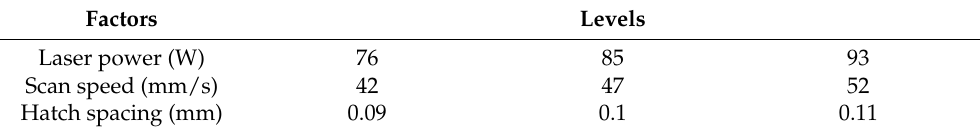
Table 1. DoE factors and levels. Factors Levels Laser power (W) 76 85 93 Scan speed (mm/s) 42 47 52 Hatch spacing (mm) 0.09 0.1 0.11 The layer thickness was fixed at 0.03 mm. The laser direction changed 90 ◦ every